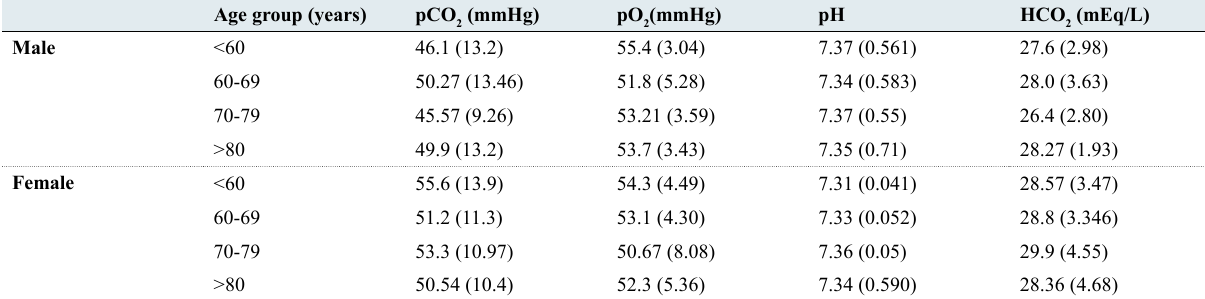
Table 2: Age and gender-wise findings of arterial blood gas tests among the study population (n=112) Age group